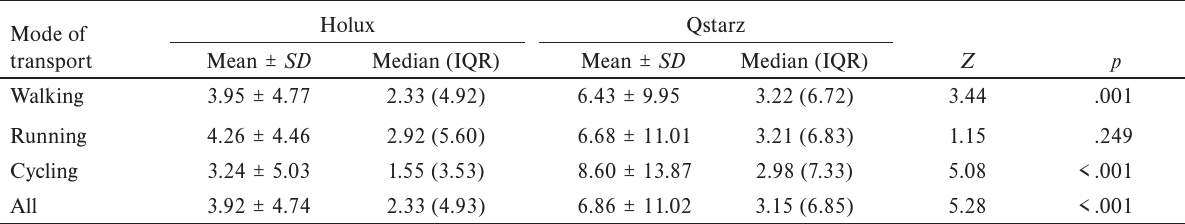
Mean and median distance of GPS points from the edge of the base lane polygon in metres Mode of transport